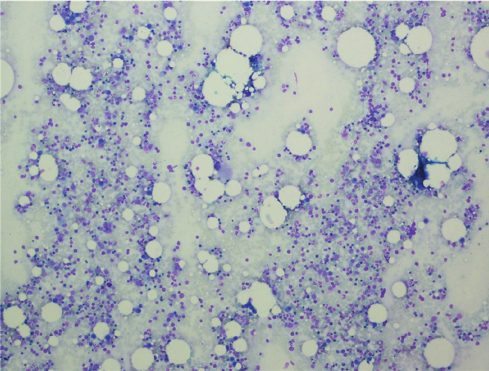
Figure 3: Low-power view of FNA cytology of lung mass shows he- matopoetic cells admixed with few fat cells. Wright stain × 100.